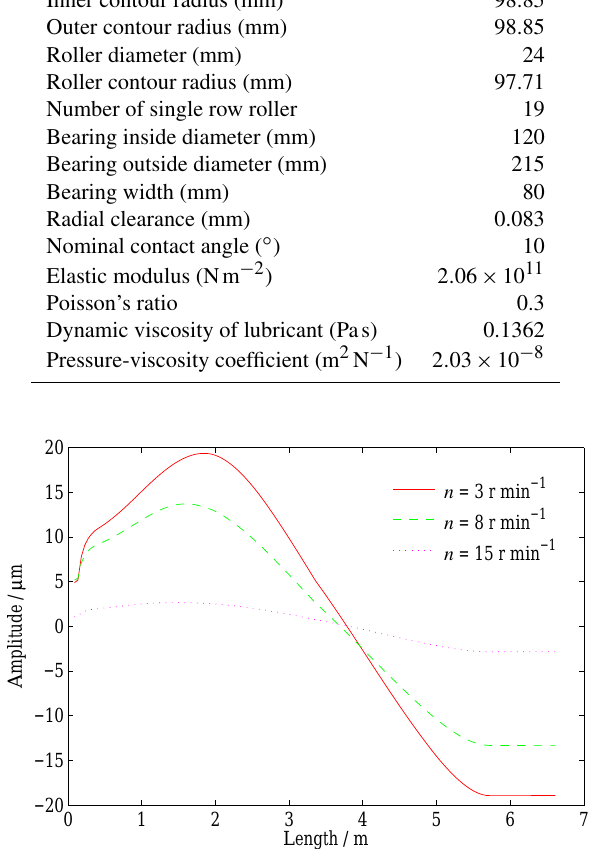
Figure 17. Effect of rotation speed on drum’s vibration amplitude.